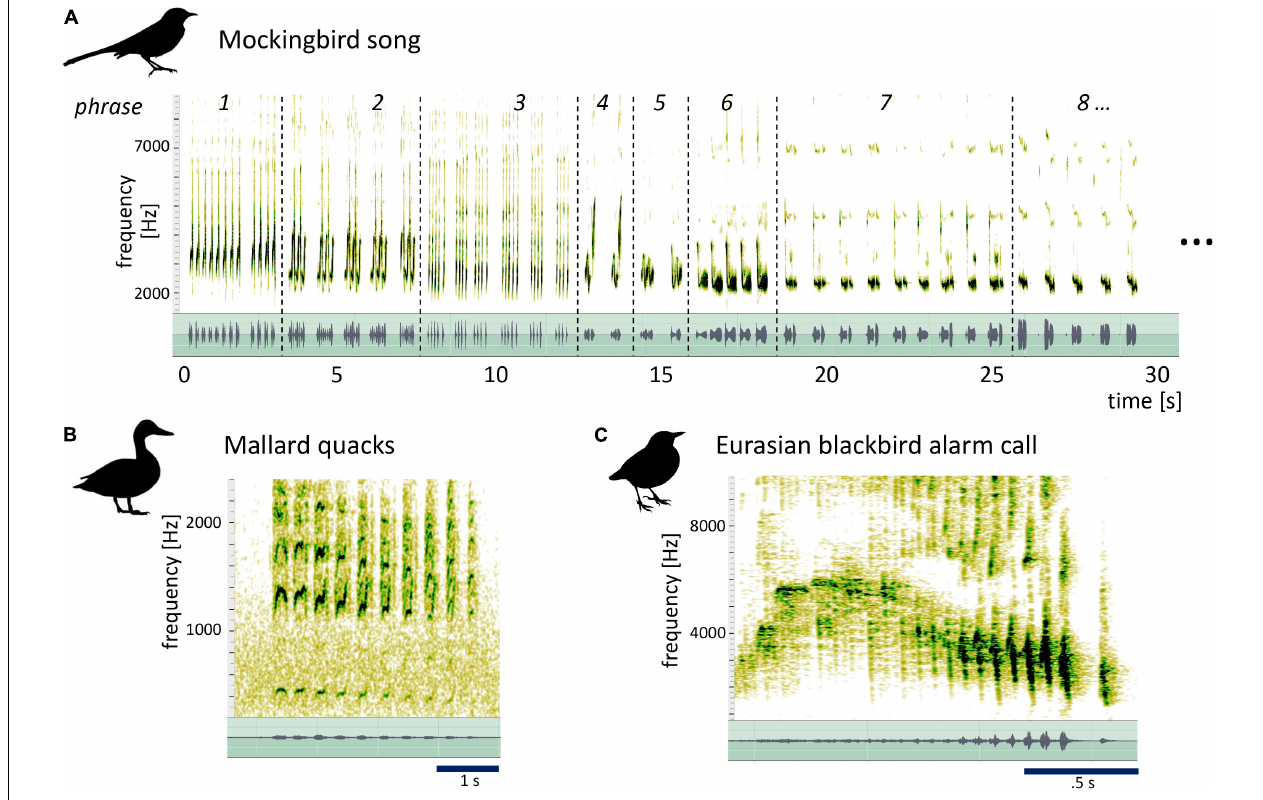
FIGURE 1 | Spectrogram (top) and waveform (bottom, green) of mockingbird song, illustrating its hierarchical structure, and mallard and blackbird calls for comparison. (A) 14 s of male mockingbird song. Dotted lines mark phrase transitions. Both spectrogram and waveform illustrate the organization of Birdsong material in distinct phrases of repeated syllables (e.g., phrase 3) or syllable groups (e.g., phrase 1). (B) A series of mallard quacks (XC613266, recorded by Jack Berteau in the Vendée, France) and (C) a blackbird’s alarm call (XC622587, recorded by Pierre Foulquier in Le Mans, France) that both contain a specific kind of acoustic morphing: one repeated note/syllable gradually slows down and descends in pitch (after an initial rise for the blackbird call). We argue here that the variegated morphing modes observed across mockingbirds’ phrase transitions are distinct from these cases of stereotyped within-phrase morphing, less easily explained by muscular constraints, and surprisingly similar to certain strategies in music. The mallard quacks and the blackbird call in Figure 1 were obtained from the Xeno-Canto database. The mallard was recorded by Jack Berteau in the Vendée, France (recording XC613266) and the blackbird by Pierre Foulquier in Le Mans, France (recording